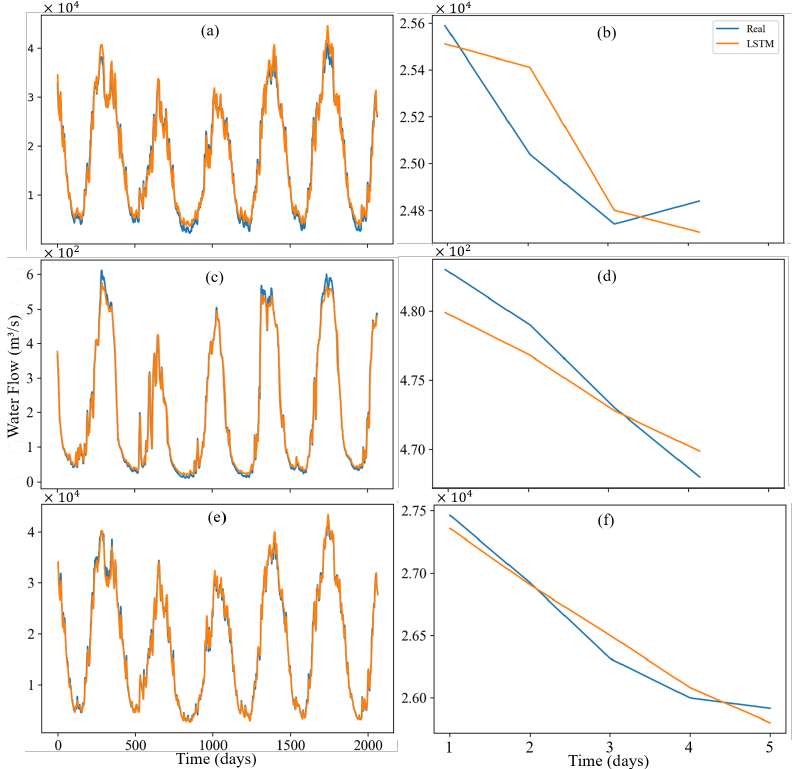
Figure 7. Prediction results of Mamoré River for ( a ) training and ( b ) testing dataset, Abunã River ( c ) training and ( d ) testing dataset and Madera River ( e ) training and ( f ) testing